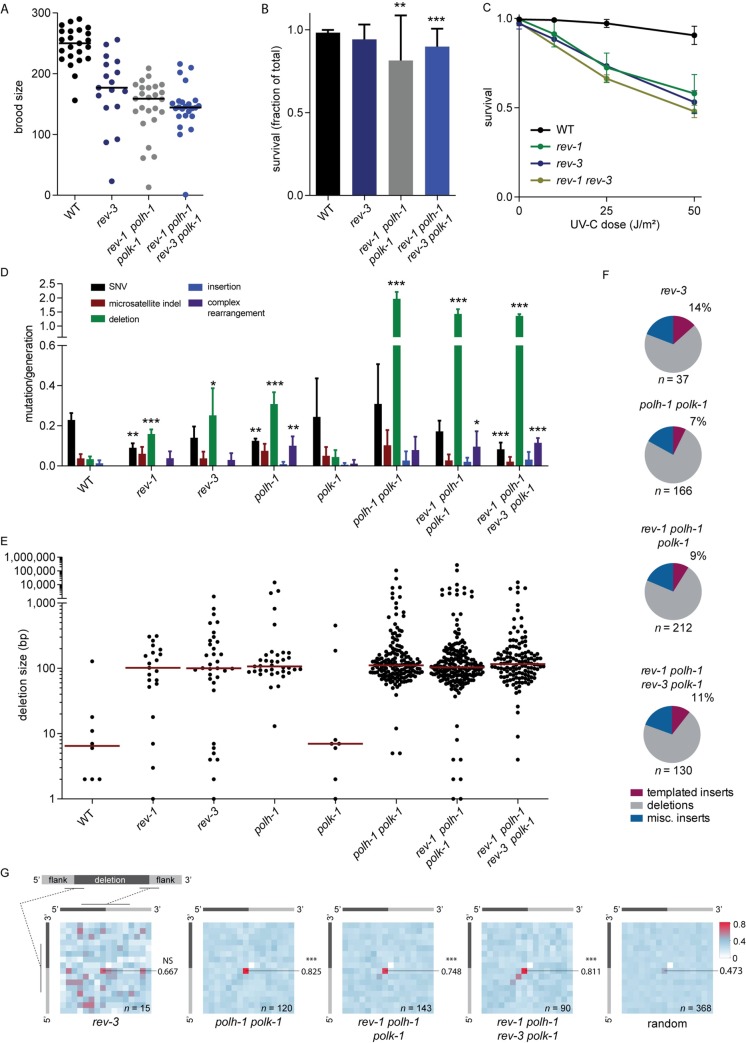
Genome protection by REV-3 and the Y-family of TLS polymerases.A) Quantification of total brood size for wild-type, rev-3, rev-1 polh-1 polk-1 and rev-1 polh-1 polk-1 rev-3 deficient animals. Each data point represents the total brood of a single hermaphrodite. B) The surviving fraction of progeny was calculated as the number of hatched eggs divided by the brood size. Error bars denote SD (** indicates p<0.01, *** indicates p<0.001, t-test). C) Progeny survival in response to UV-C exposure to hermaphrodites of the indicated genotype. Error bars denote SEM. D) WGS analysis of WT and TLS deficient animals grown for 20–60 generations. Per genotype at least three independent populations were analyzed, except for polh-1 where only two independent populations were analyzed. Error bars denote SD (* indicates p<0.05, ** indicates p<0.01, *** indicates p<0.001, t-test). E) Size plot for deletions that accumulate in the genomes of the indicated genotypes. Red line represents median size (log10 scale). F) Pie charts visualizing the subdivision of all deletions into three categories: i) simple deletions, ii) templated insertions, which represent deletions carrying insertions that were of sufficient size (≥5bp) to be mapped to their origin in the immediate vicinity of the junctional sequence (<40bp surrounding the deletion breakpoints), iii) miscellaneous (misc.) insertions, which are deletions that also contain insertions, but which were below 5bp in size, or were of unknown origin. G) Heatmap representations of micro-homology present at deletion junctions, with a schematic representation illustrating the methodology: for every deletion, each position of the upstream breakpoint is compared to each position of the downstream breakpoint. Identical nucleotides score 1, non-identical score 0. Subsequently, a heat map is constructed by summing all scores for all events at each position divided by the number of events. For reference purposes, a heat map was constructed from all (368) deletions in the various genotypes, but with flank sequences shuffled in silico. Of note, all alleles are annotated in keeping with maximal 5’ conservation, which here dictates that the base at the -1 position at the 5’ side is never identical to the +1 position at the 3’ side: in such a case, that base will shift to the +1 position at the 5’ side. As a consequence of this rule, the position marked by a white square will have no microhomology score, while the +1,-1 position is slightly elevated. The extent of this methodological skewing can be noticed in the analysis of the random set of deletions. Number next to heatmap represents the fraction of micro-homology at the indicated location (NS—non-significant, ***—p<0.001, chi-square test compared to random set).